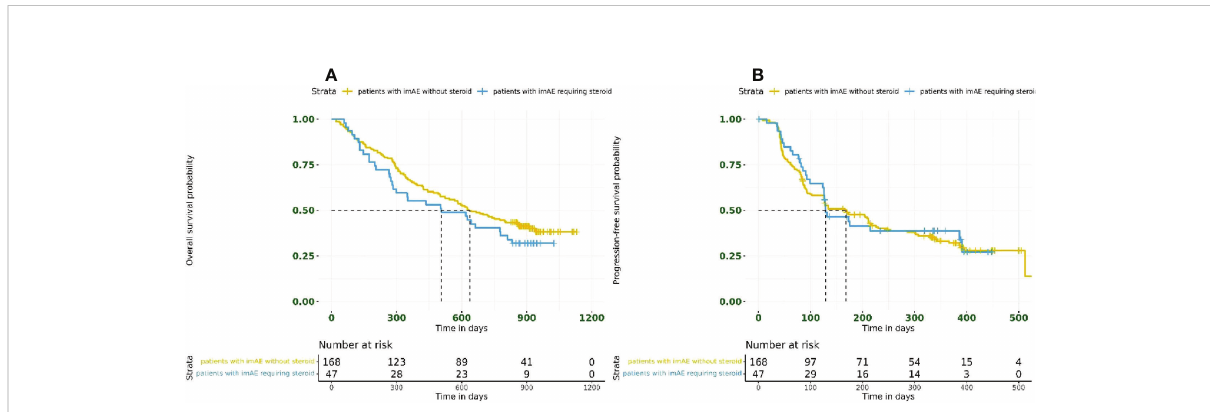
FIGURE 4 Kaplan – Meier plots for (A) overall survival and (B) progression-free survival based on steroid usage in patients with imAEs from the immunotherapy arms combined ( n = 215). imAE, immune-mediated adverse